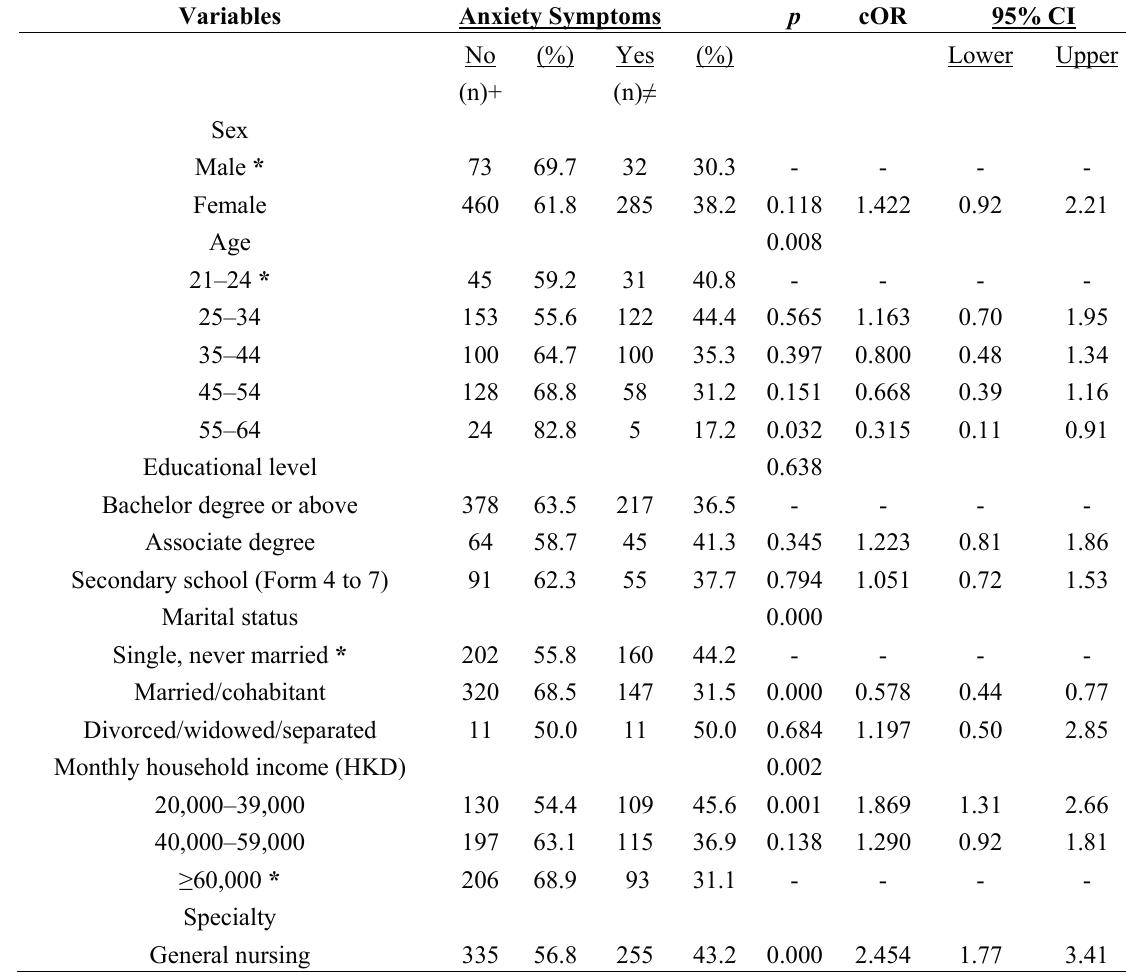
Table 3. Frequency distribution of respondents by anxiety status and socio-demographic characteristics and other selected